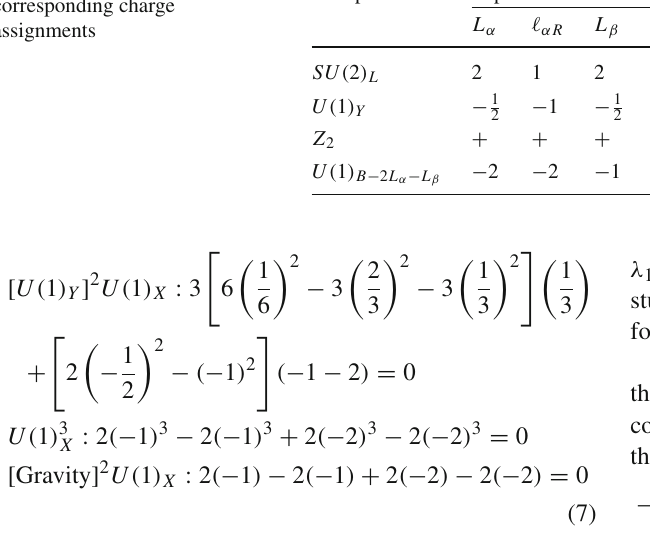
Table 1 Particle content and Group Lepton fields Scalar corresponding charge assignments